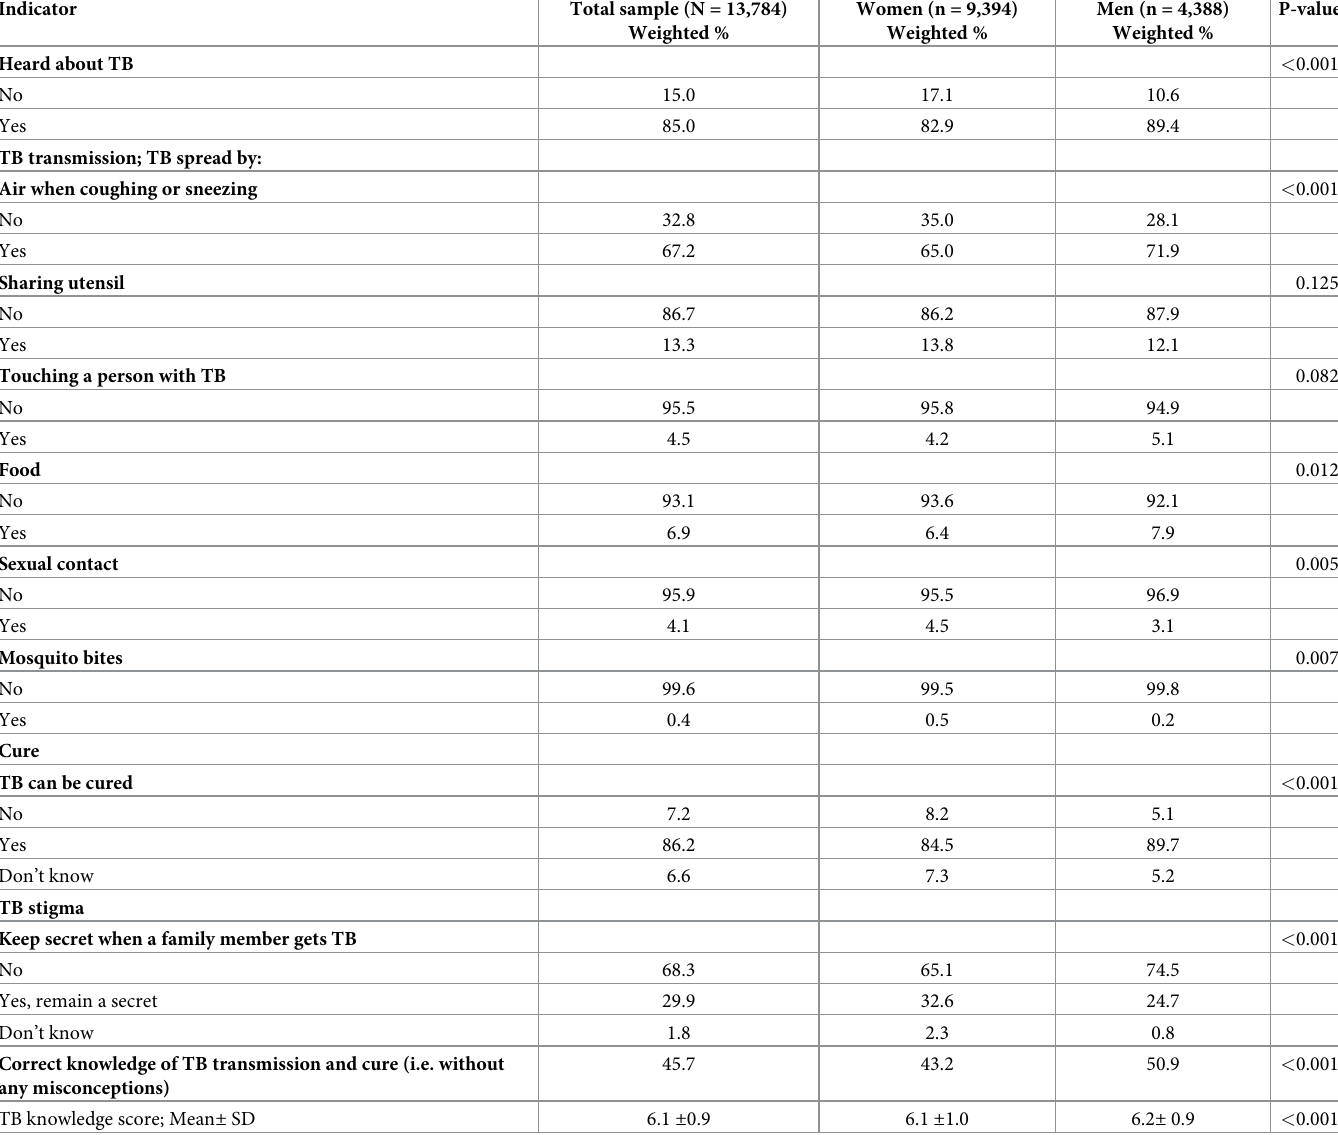
Table 2. Gender differences in tuberculosis awareness, knowledge regarding disease transmission and cure, and stigma (N = 13,784). Indicator Total sample (N = 13,784) Weighted